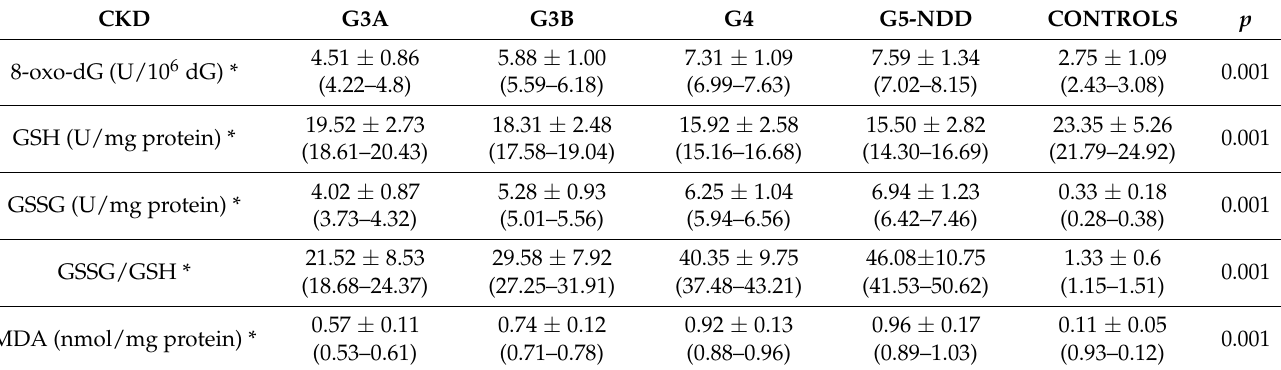
Table 5. Assessment of oxidative parameters according to stage.